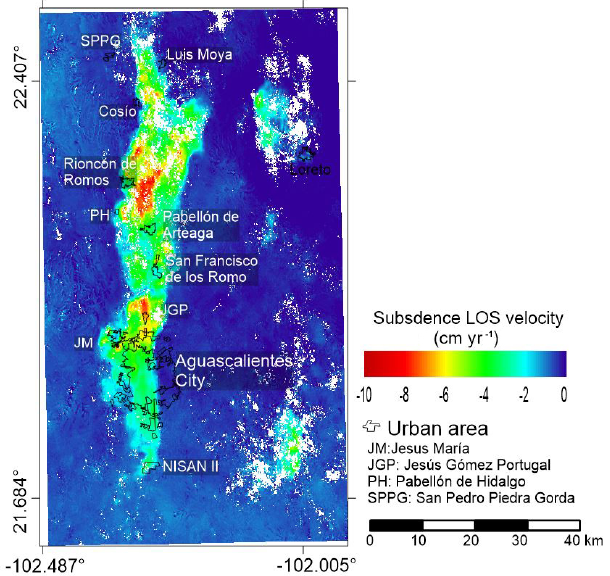
Figure 2. Subsidence LOS velocity map of Aguascalientes valley. Modified from Pacheco-Martínez et al. (2015).